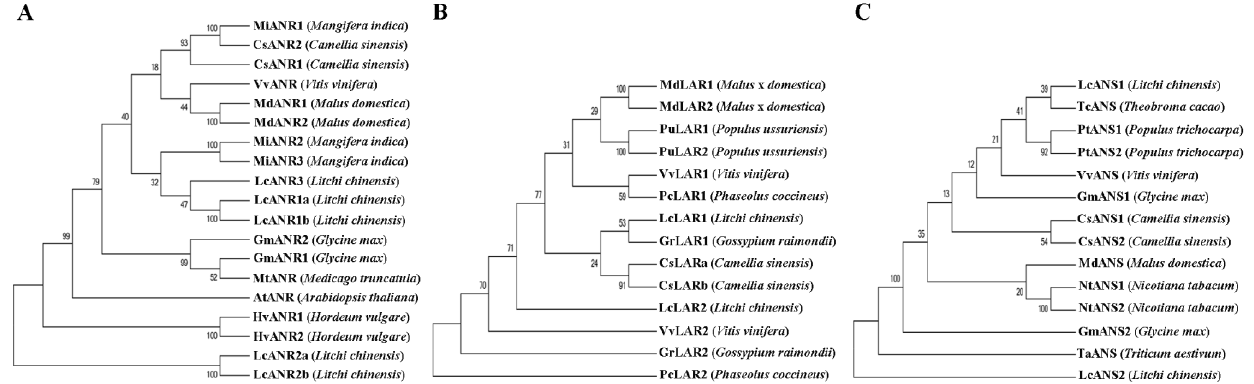
Figure 6. Rooted neighbor-joining phylogenetic trees of the full-length amino acid sequences of